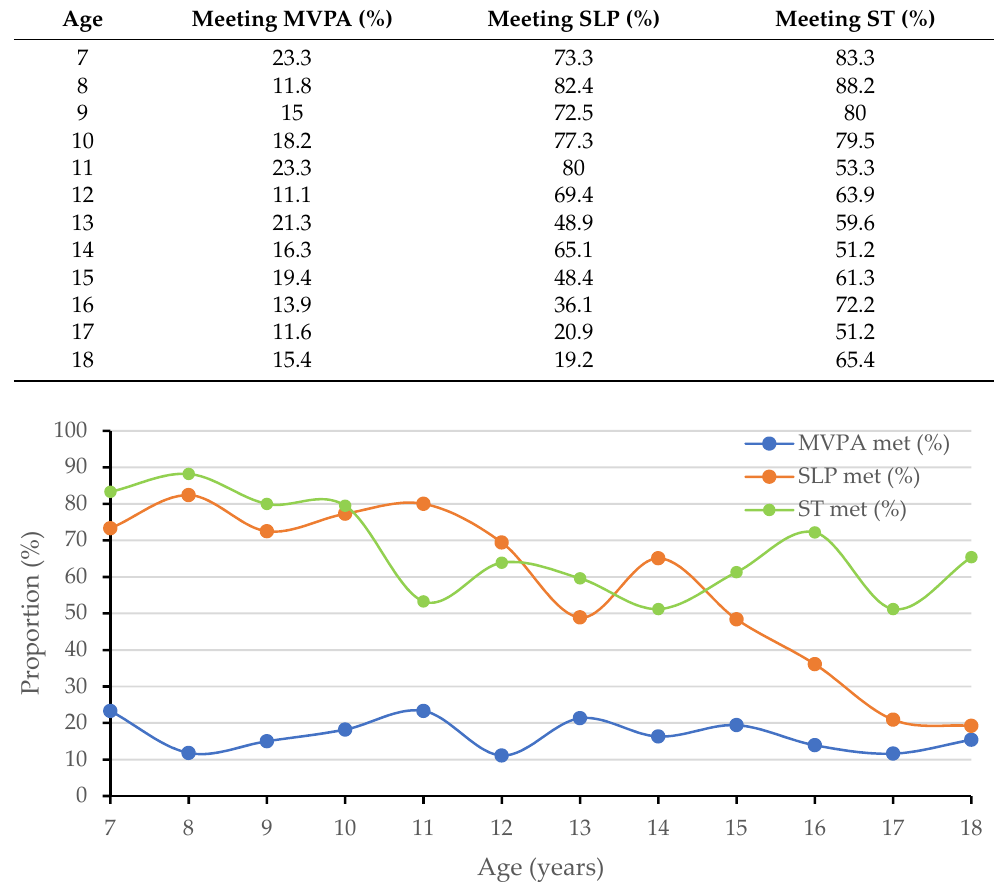
Figure A1. Compliance rates for three guidelines in Chinese children and adolescents aged 7–18. Table A3. Comparison of BMI between children and adolescents who meet ST guideline or not. Meeting ST Mean